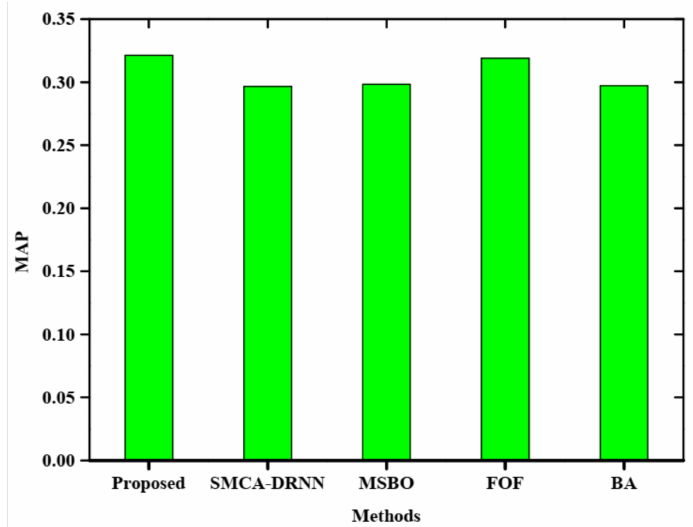
Figure 3. Comparative analysis of MAP without query expansion.